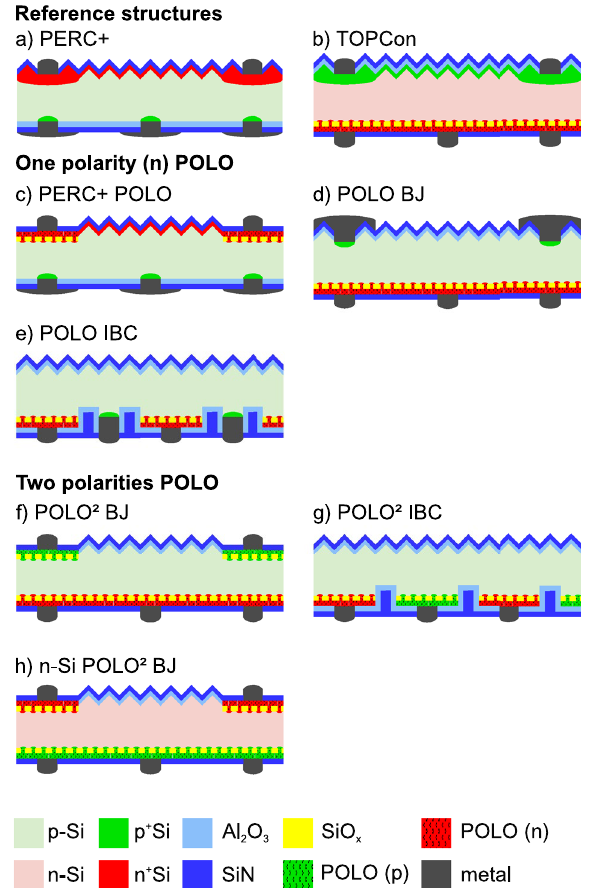
Figure 3. Cell structures discussed in this study. Top row: reference structures ( a ) the PERC+ cell and ( b ) the TOPCon structure. 2nd and 3rd row: concepts featuring n-type POLO junctions and Al contacts: ( c ) PERC+ POLO, ( d ) POLO BJ and ( e ) POLO IBC. 4th and 5th row: concepts featuring POLO junctions for both polarities ( f ) based on p-type Si in BJ configuration, ( g ) based on p-type Si in IBC configuration and ( h ) based on n-type Si in BJ